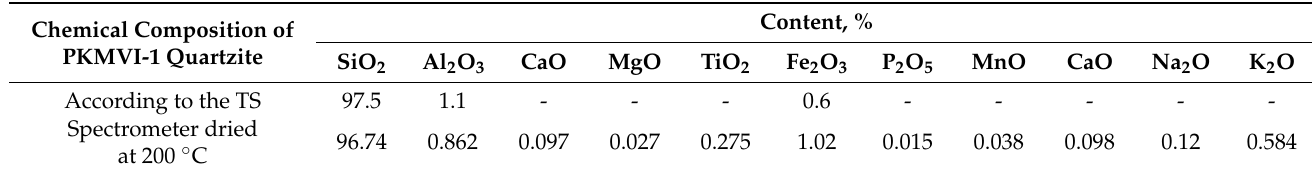
Table 2. The chemical compositions of quartzite grade